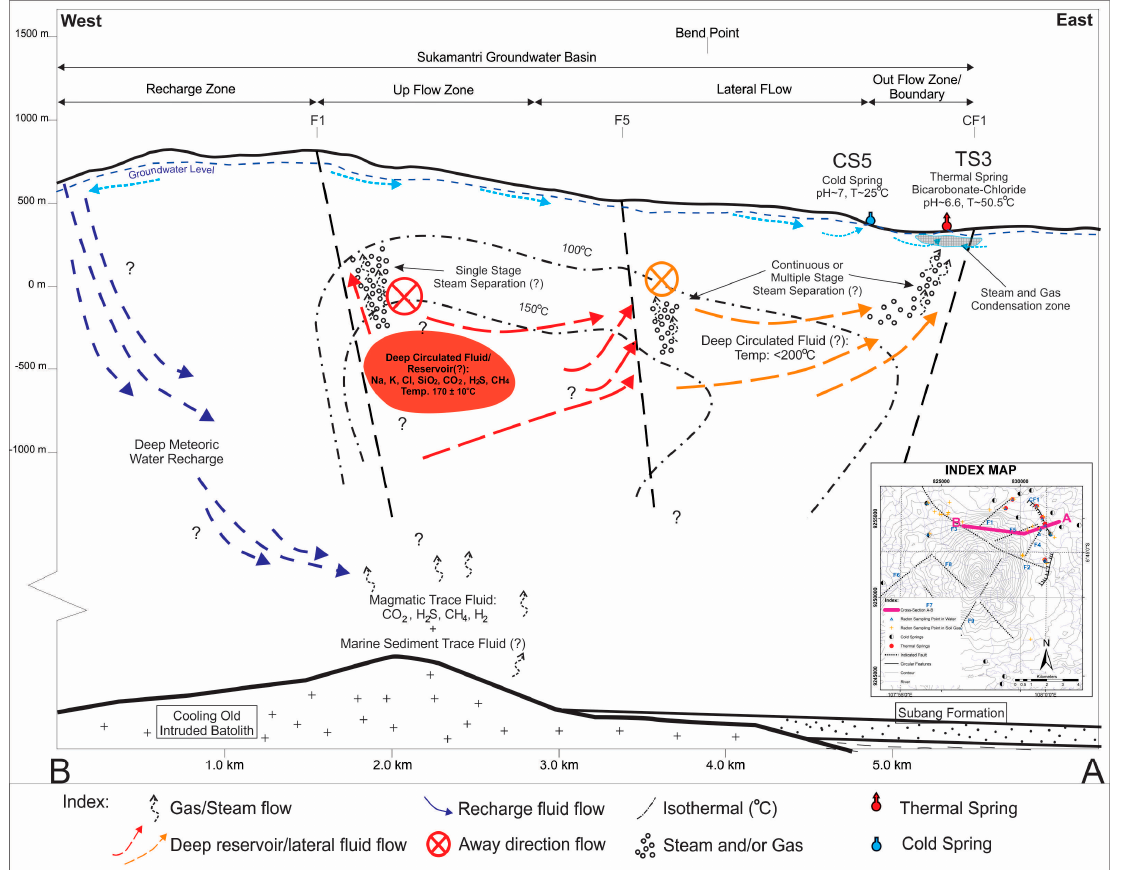
Figure 16. A tentative deep hydrogeological model of the Tampomas geothermal system from an E- W section cutting across three main faults: F1, F5 and CF1. The deep circulated fluid temperature is based on geothermometer calculation.